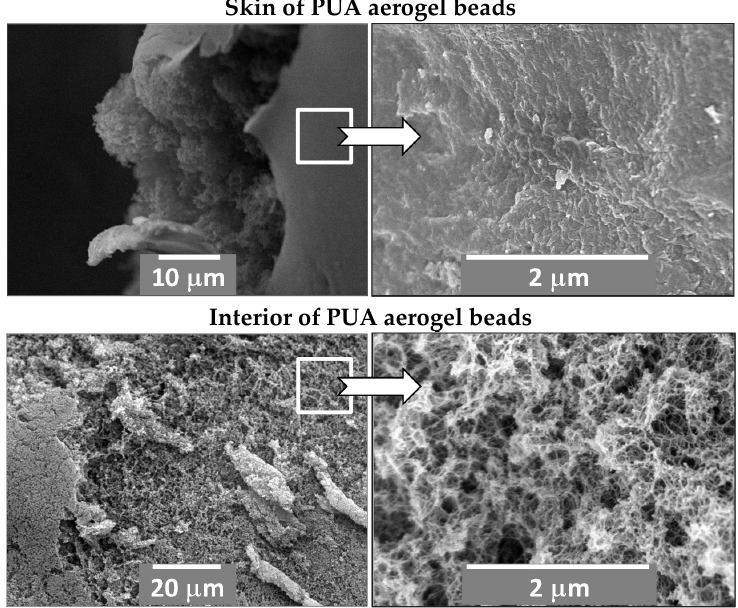
Figure 4. Scanning electron microscopy (SEM) images of spherical PUA aerogel beads at different magnifications: skin ( top row) and interior ( bottom row).